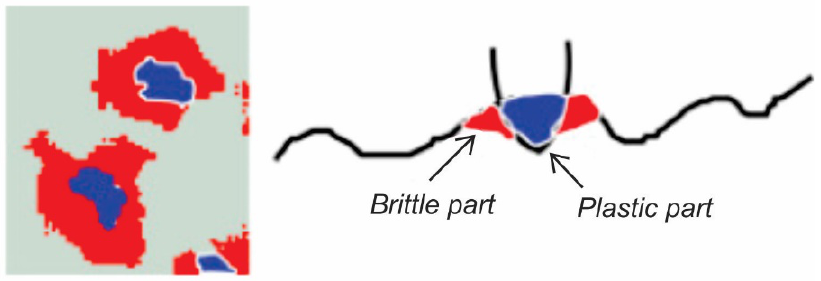
Figure 4. Scheme of rock craters generated by teeth [41 ].